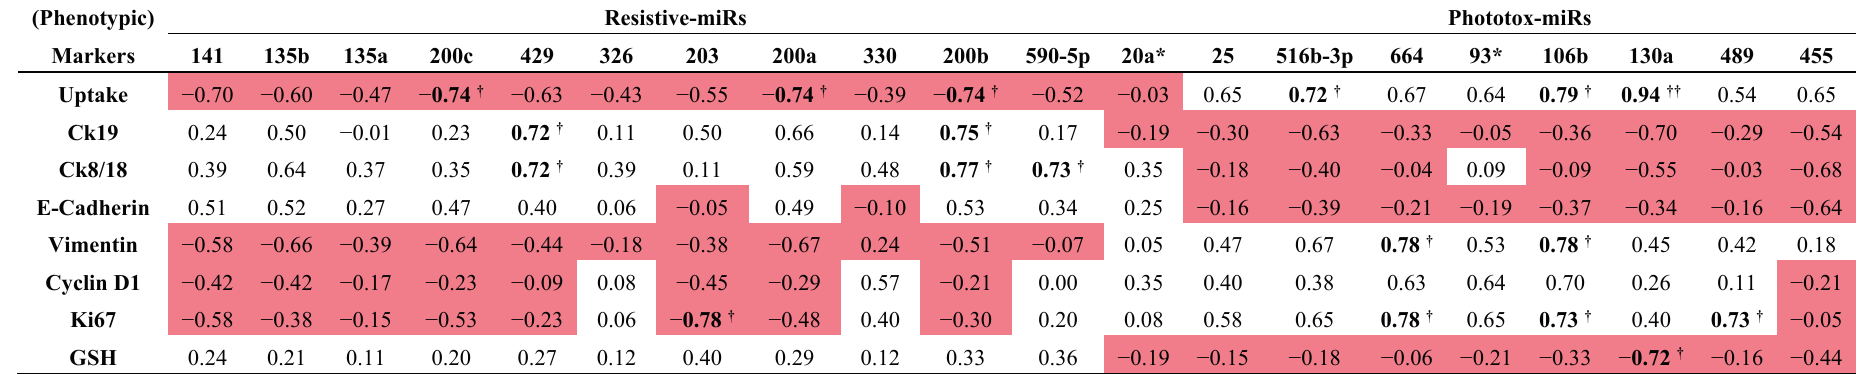
Table 2. Correlation analysis a,b —miR expression and markers of proliferation and differentiation, GSH levels and PS uptake c